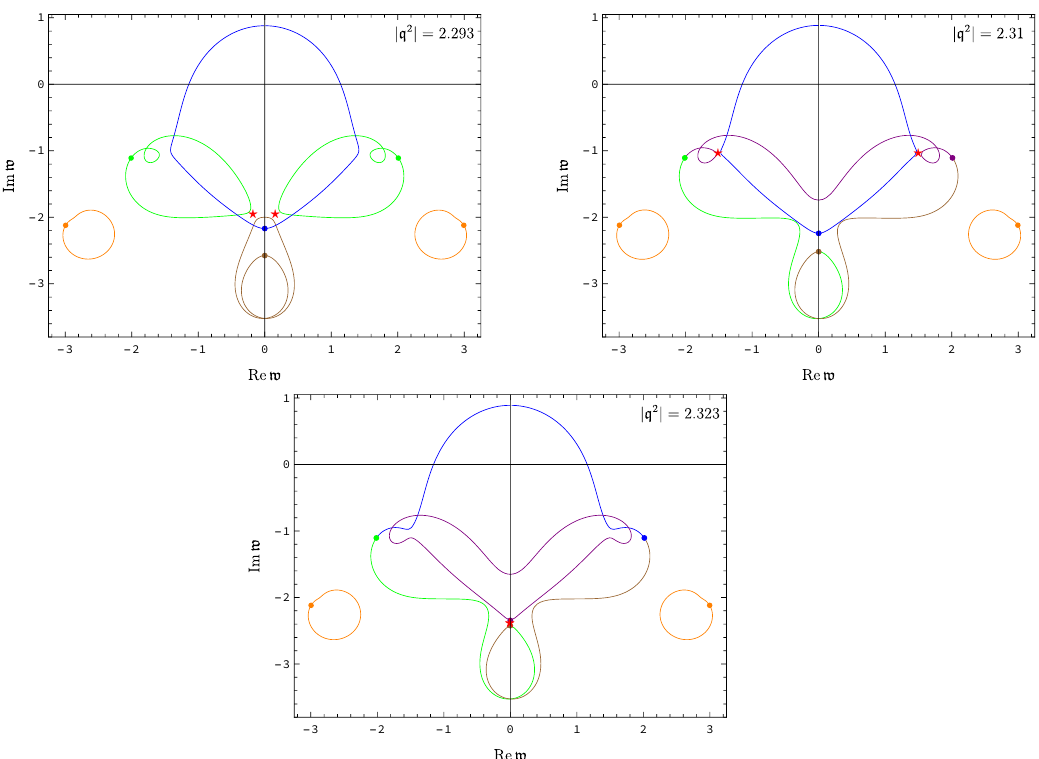
Figure 7 . Quasinormal spectrum in the shear channel at γ = 2 · 10 − 5 , computed non-perturbatively in γ . The level-crossing occurring at the smallest value of | q 2 | (top left panel) does not affect the hydrodynamic mode (shown in blue colour). The first (smallest in | q 2 | ) critical point of the shear mode arises from the level-crossing with the top gapped modes (top right panel). This point sets the radius of convergence of the hydrodynamic series. The critical point with an even higher value of | q 2 | is shown in the bottom panel.